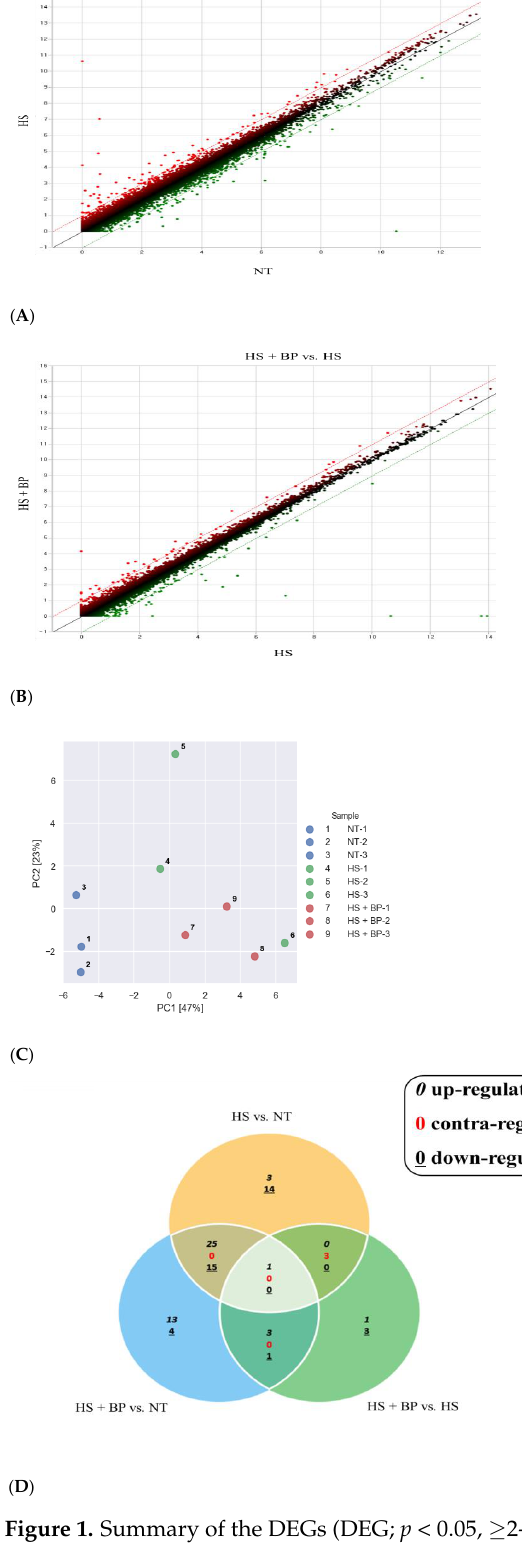
Figure 1. Summary of the DEGs (DEG; p < 0.05, ≥2-fold change) in the porcine jejunum under HS and fed dietary BP: ( A ) Scatter plot in HS vs. NT; ( B ) Scatter plot in HS + BP vs. HS; ( C ) PCA analysis based on DEGs of the NT, HS, and HS + BP groups; ( D ) Venn diagrams indicating DEGs; NT, normal temperature; HS, heat stress; HS + BP, dietary beet pulp under heat stress.